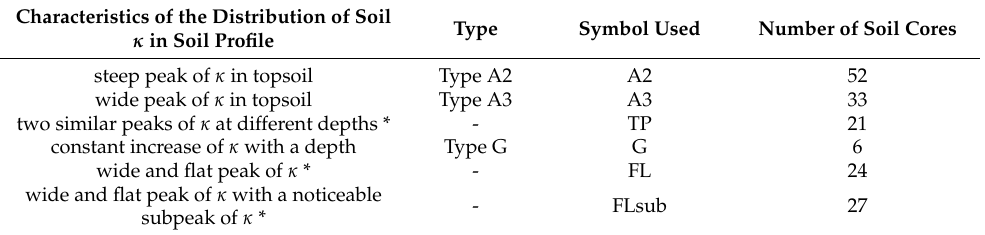
Table 4. Types of κ distributions in soil profile and number of collected soil cores assigned to each type; the asterisk denotes the new types specified in this